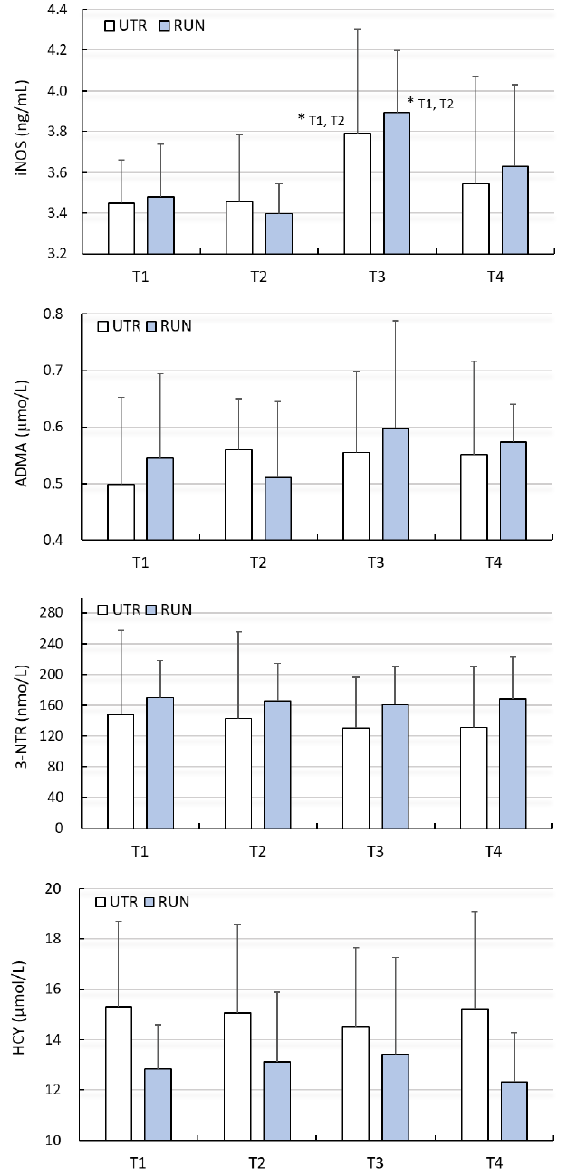
Figure 1. Concentration of inducible nitric oxide synthase (iNOS), asymmetric dimethylarginine (ADMA), 3-nitrotyrosine (3-NTR) and homocysteine (HCY) in blood plasma (mean ± standard deviation) in long-distance runners (RUN) and in untrained individuals (UTR) during the period of systemic cryotherapy (WBC) treatment and 7 days after its completion. *—statistically significant difference vs. T1 and T2 (p < 0.05); T1—measurement before 1 WBC, T2—measurement after 12 WBC, T3—measurement after 24 WBC, T4—measurement 7 days after completing WBC treatments.